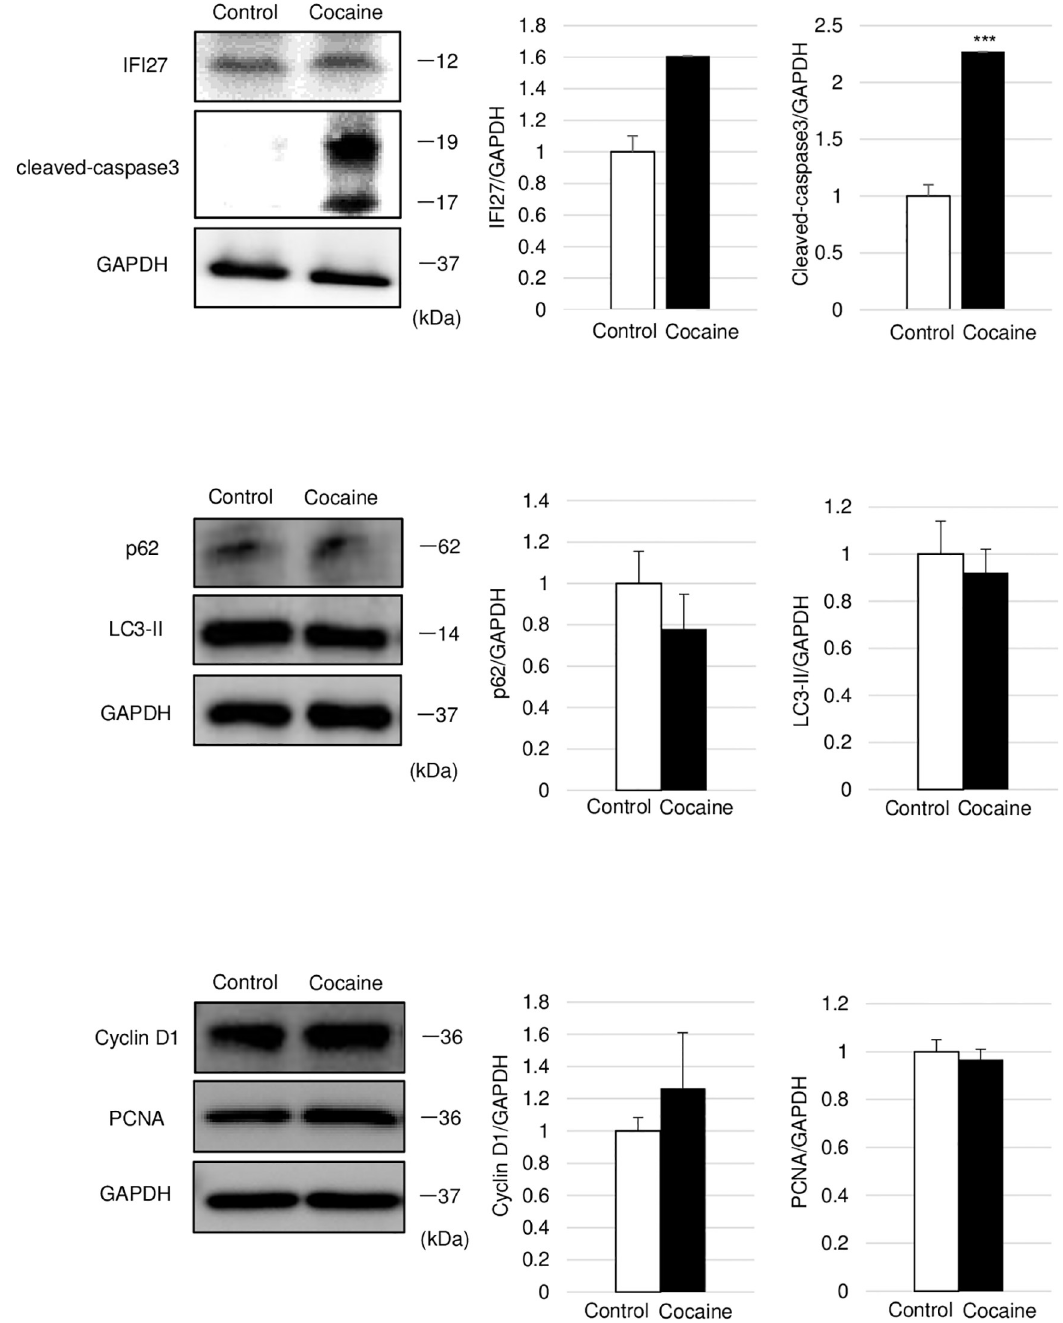
Fig 3. Apoptosis in thymus from cocaine-administered rats. Rats were treated with or without cocaine (20 mg/kg/day, 7 days). Proteins were extracted from the thymus and subjected to immunoblot analysis. Markers of apoptosis (IFI27 and cleaved-caspase 3), cell cycle (cyclin D1 and PCNA), and autophagy (LC3 and p62) are shown. GAPDH levels served as an internal control. Graphs show mean and S.E. ��� P < 0.001 versus control.